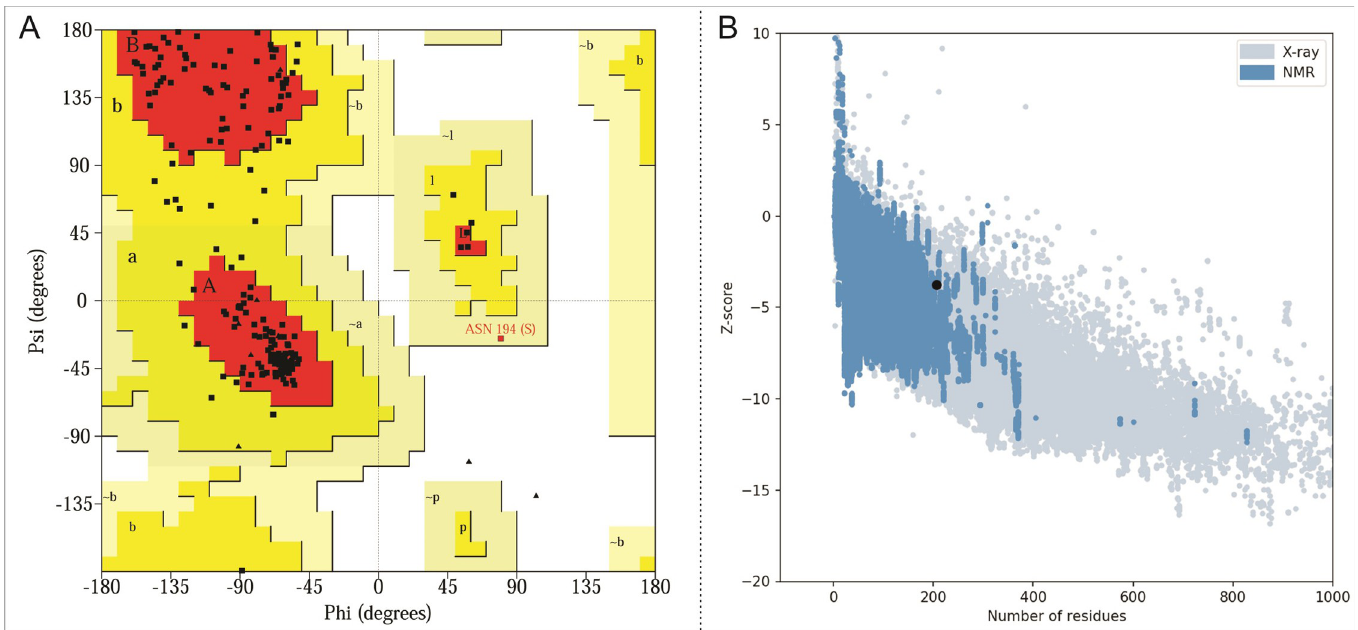
Fig 4. (A) Ramachandran plot of the YBMV CP model. The plot was created using the PROCHECK program. (B) Protein Structure Analysis (ProSA) of model YBMV CP. The overall quality of the YBMV CP model shows the z-score value of -3.75 (Native conformation to its template).